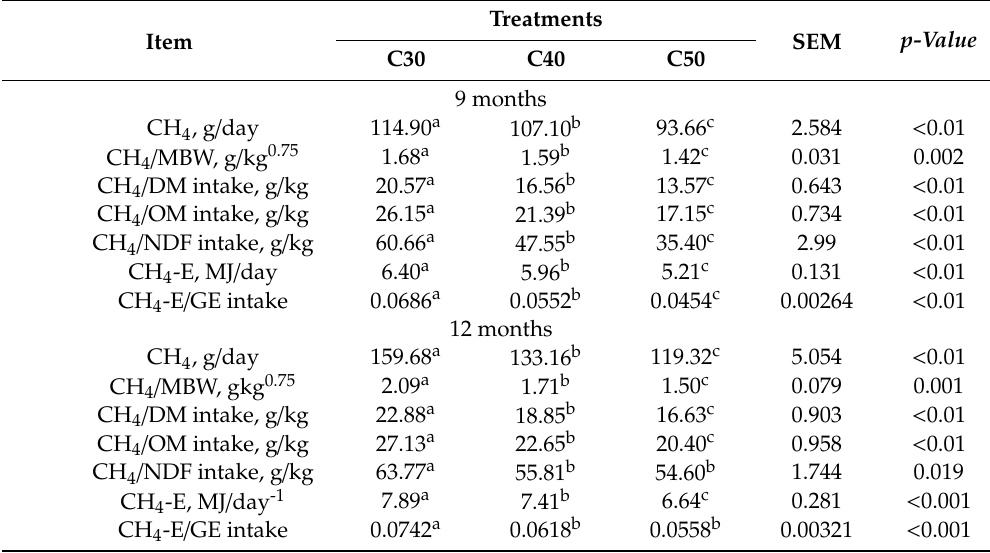
Table 4. E ff ects of di ff erent dietary concentration level on enteric methane (CH 4 ) emissions of Holstein cows at age of 9, 12 and 15